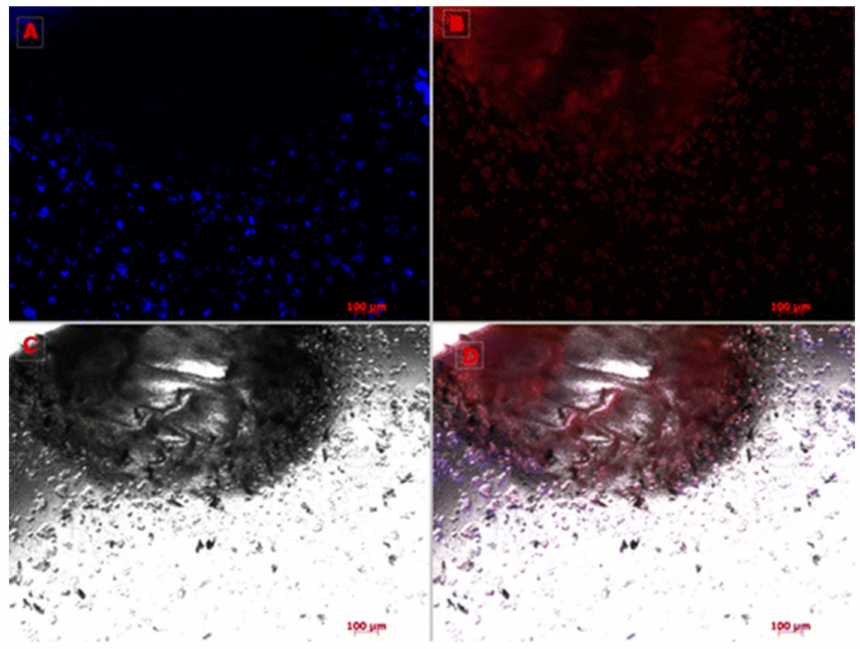
Figure 12. Thermoablation of RGO/CJ-PEGBT treated MCF-7 cells obtained with an 810 nm laser fitted at 7 × 10 –2 W mm –3 : blu nuclei ( A ), red doxorubicin ( B ), bright field ( C ), merging of all fluorescence ( D ); magnification 5 × . Reproduced with permission from [215]. Copyright 2015, American Chemical Society.